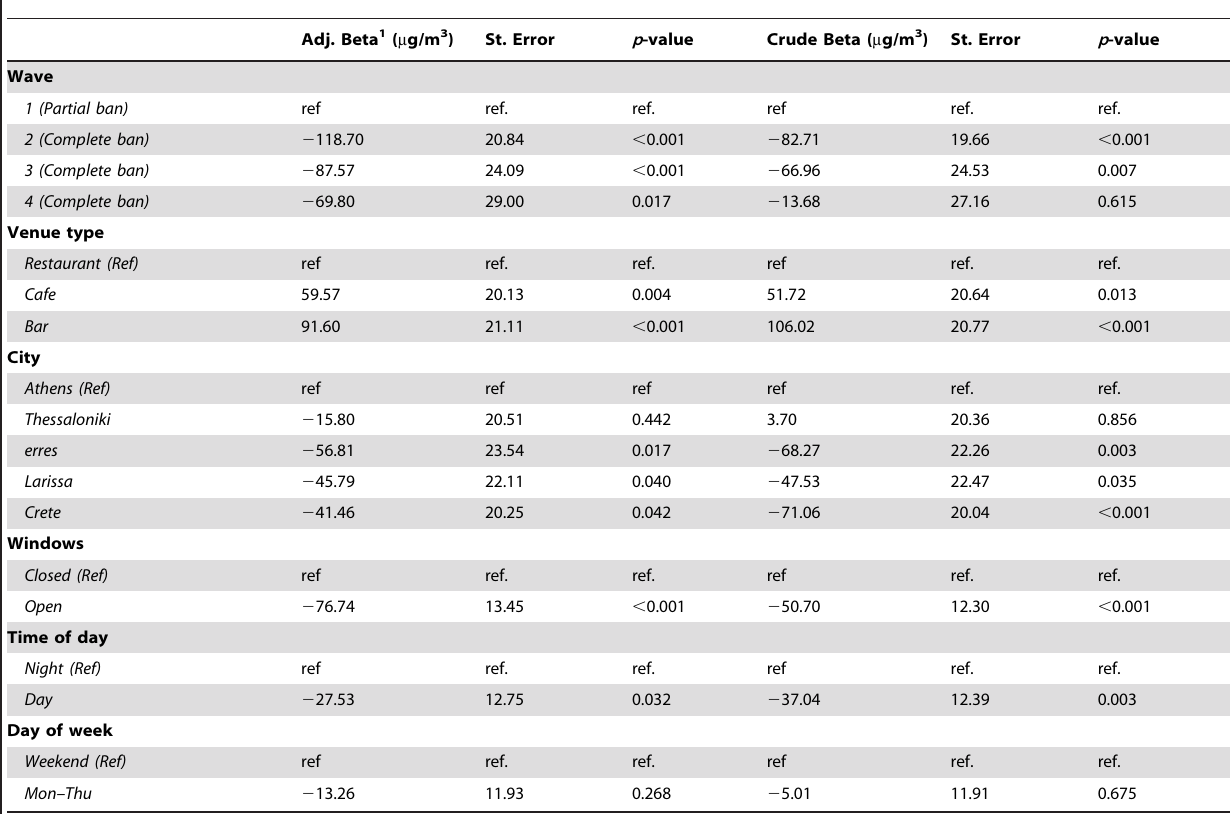
Table 3. Factors associated with indoor PM 2.5 exposure attributable to SHS exposure in venues (N =455) throughout Greece, the Hellenic Air Monitoring Study, 2010–2011.